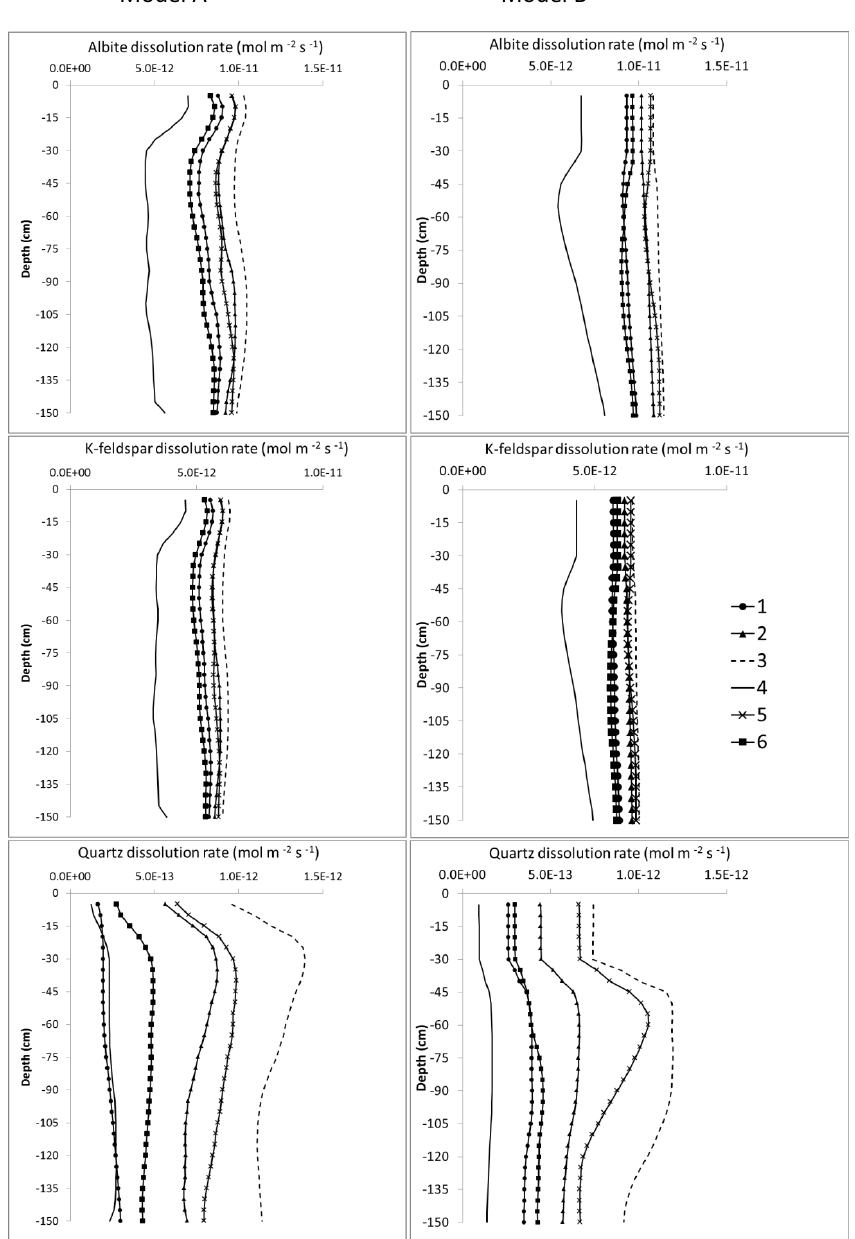
Figure 5. Effect of initial texture (shown in Table 1) on the depth distribution of silicate dissolution rates. The rates shown are taken from granite parent material and are averaged over a 15000-year simulation